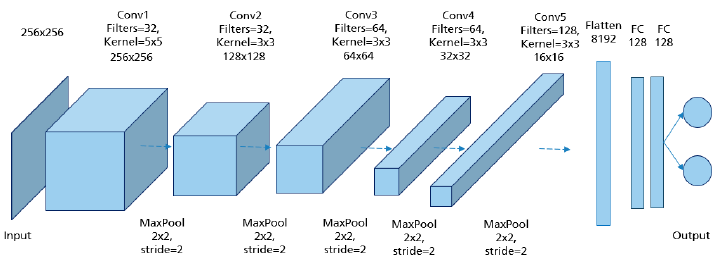
Figure 17. Model architecture of the implemented CNN for assessment of the pectoralis muscle angle with the best performance.